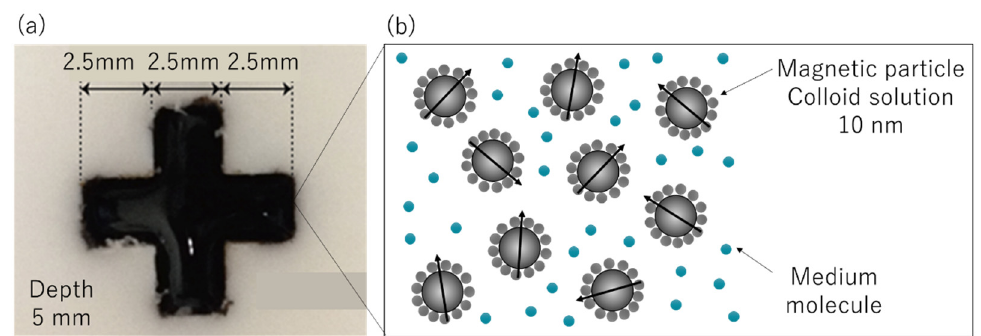
Figure 9. A magnetic-particle-containing sample used in the measurements: ( a ) optical image of the sample; ( b ) schematic of the sample structure.